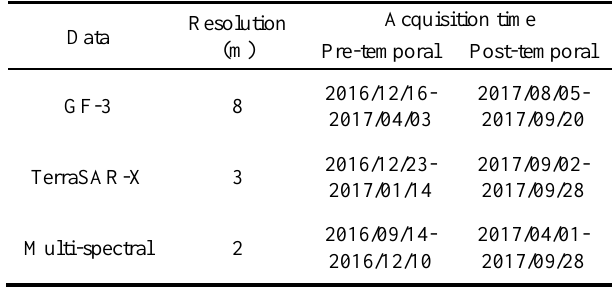
Table 6. List of data acquisition